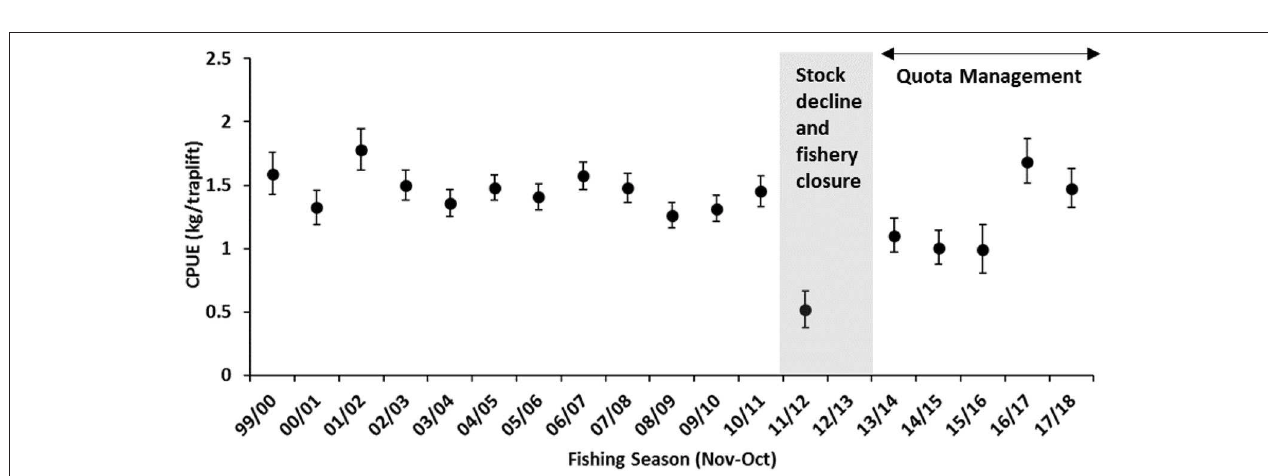
FIGURE 3 | Standardized commercial crab trap legal-size catch rate (mean ± 95% CI) (kg/traplift) for the Shark Bay Crab Managed Fishery.